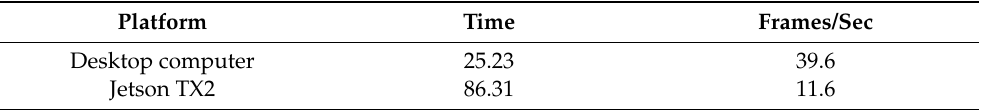
Table 10. Comparisons of processing speed by the proposed method on desktop computer and embedded system (unit: